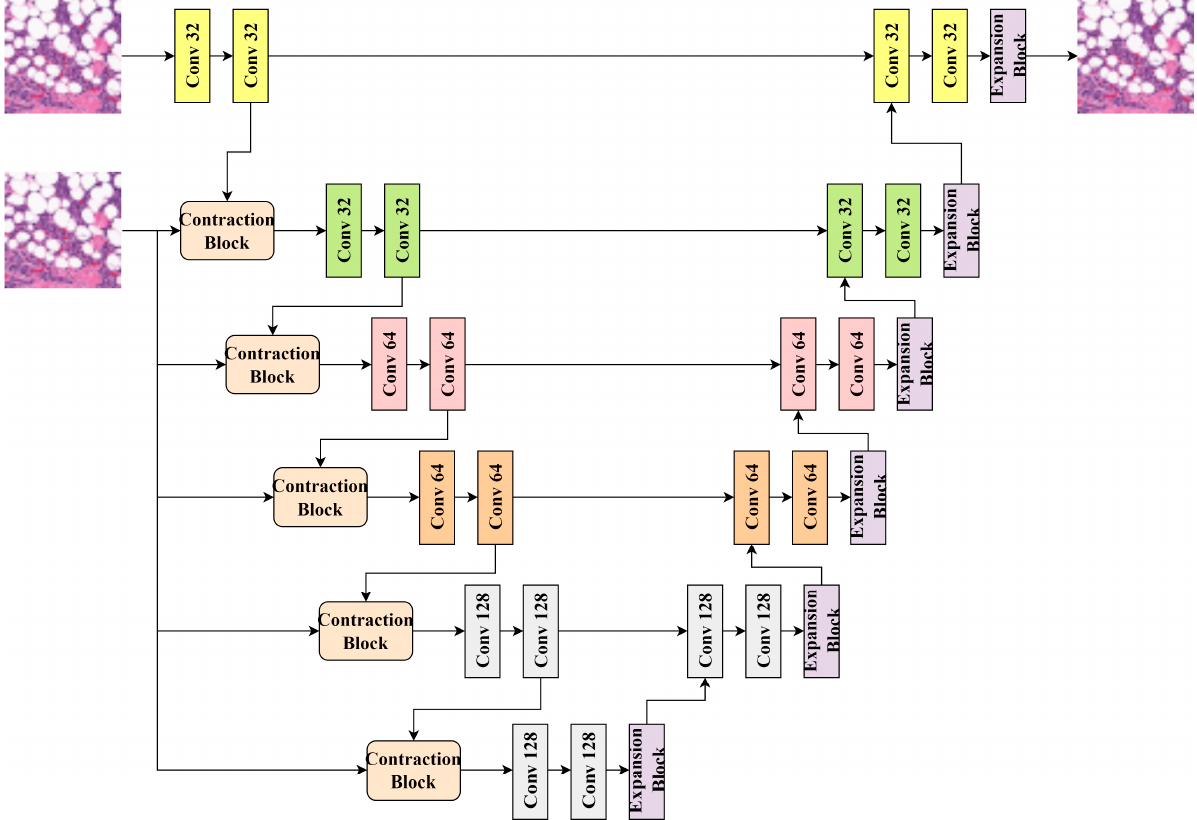
Figure 8. Design of the 3D U-Net classification model.